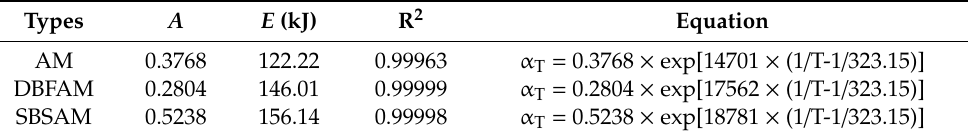
Table 6. The fitting results of the shift factors.